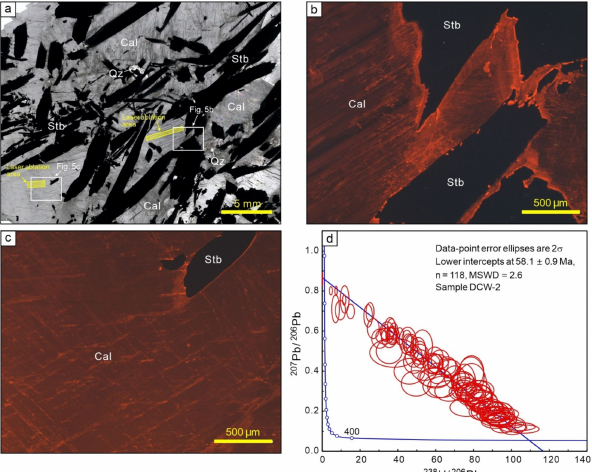
Figure 5. ( a ) Photomicrograph showing the calcite coexisting with stibnite (sample DCW-2, under plane-polarized light) in calcite-stibnite vein, and the areas of LA-MC-ICP-MS calcite U-Pb isotope analyses (yellow area). ( b , c ) Cathodoluminescence (CL) images of syn-stibnite calcite crystals from the Xikuangshan Sb deposit. ( d ) Tera–Wasserburg concordia diagram of LA-MC-ICP-MS U-Pb data of syn-stibnite calcite crystals in calcite-stibnite vein. Error ellipses are at 2 σ . MSWD = mean standard weighted deviation. Abbreviations as in Figure 3.